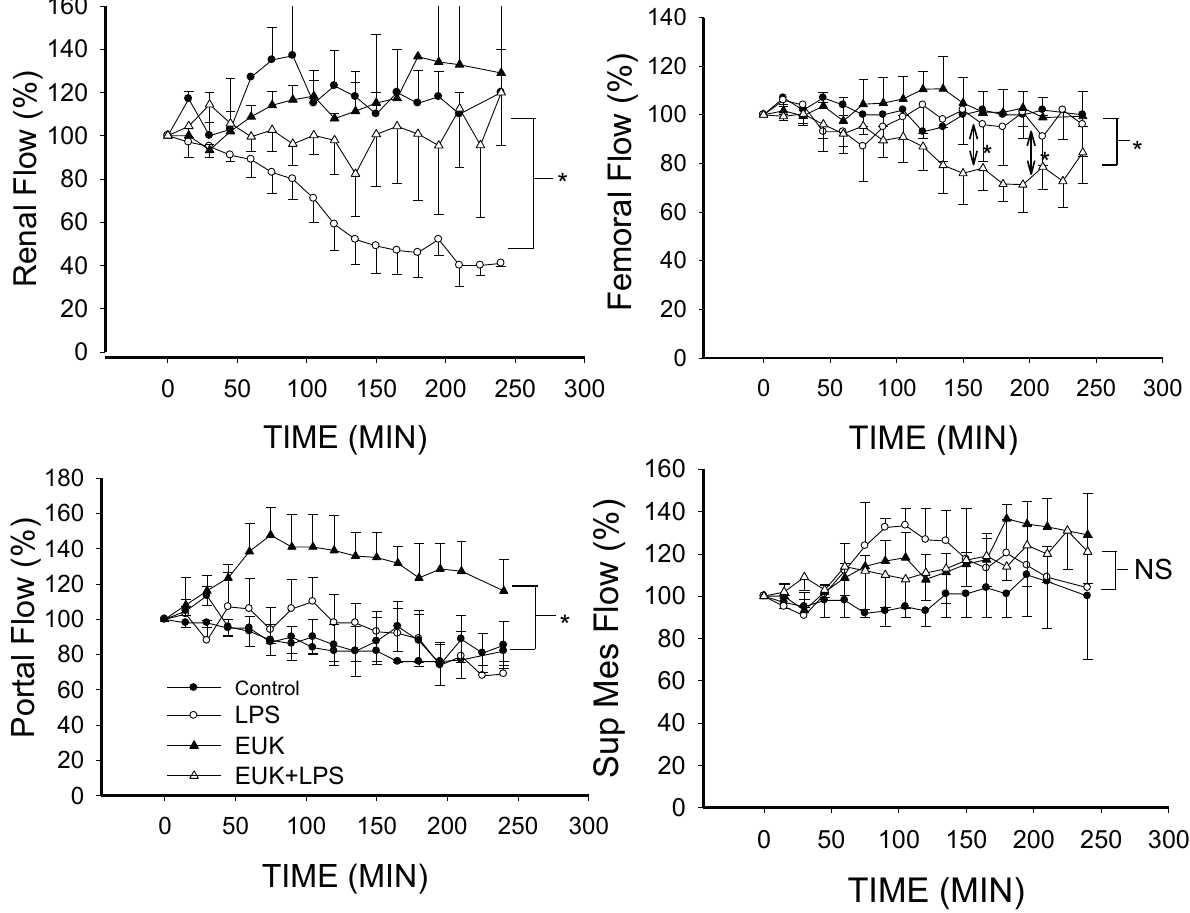
Figure 5. Mean blood flows in different vascular beds as a percent of baseline over time for the four conditions (mean ± SEM). Upper left , renal arterial flow; Renal artery flow was lower in the LPS group than the other three groups ( p < 0.001 for each condition); Lower left , portal venous flow; Portal flow was higher in the EUK-134 alone group than in the other three conditions ( p < 0.001); Upper right , femoral arterial flow; Femoral flow in the LPS plus EUK-134 group was lower than the other three groups ( p < 0.001); and Lower right , superior mesenteric flow; There was no difference among the four conditions. * p < 0.001; NS: not statistically